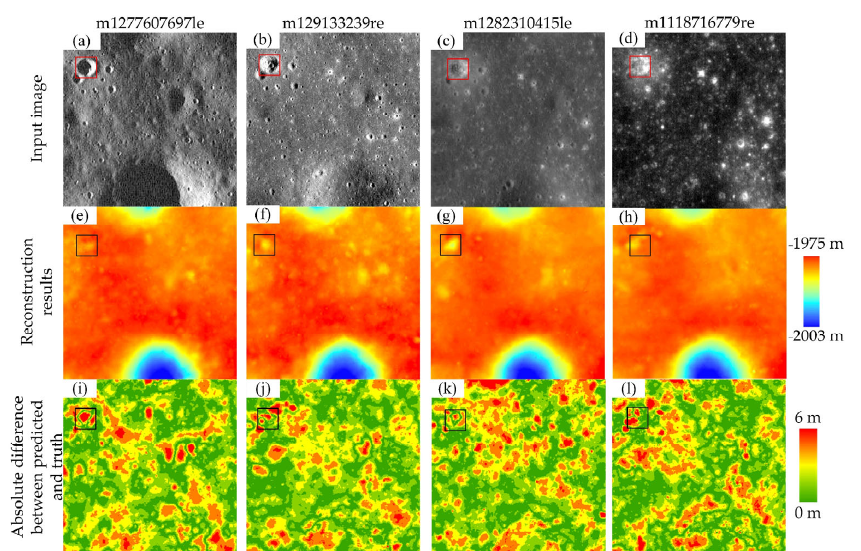
Figure 8. Comparison of reconstruction results using images captured at different solar altitude angles. Each column shows one result of one image. Row 1: the input image of LROC NAC image, solar altitude angle: m1277607697le, 5.04°; m129133239re, 36.87°; m1282310415le, 60.55°; m1118716779re, 76.14°. Row 2: the reconstruction results. Row 3: the difference between the reconstruction results (2 m/pixel) and the LROC NAC DEM (ground truth, 2